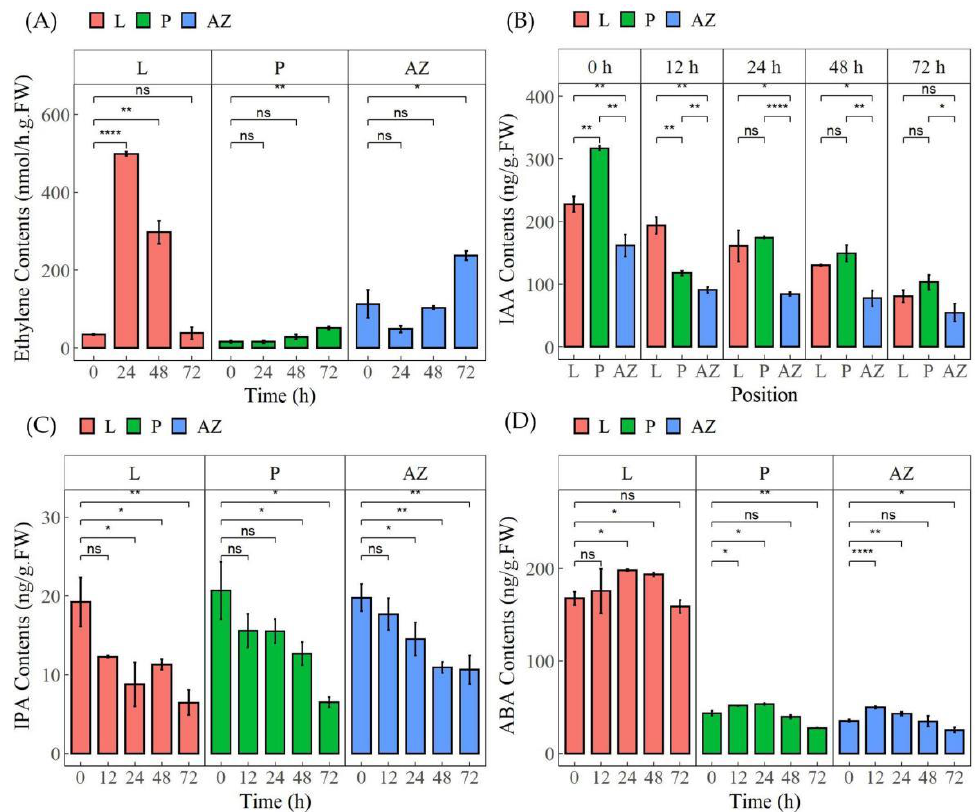
Figure 10. TDZ modulates the accumulation of ethylene ( A ), IAA ( B ), IPA ( C ), and ABA ( D ) in leaf, petiole, and AZ of cotton. Cotton leaves were treated with 750 mg/L TDZ. Leaf, petiole, and AZ were sampled at 0, 12, 24, 48, and 72 h after treatment and subjected to detect hormonal content. * p < 0.05, ** p < 0.01, **** p <